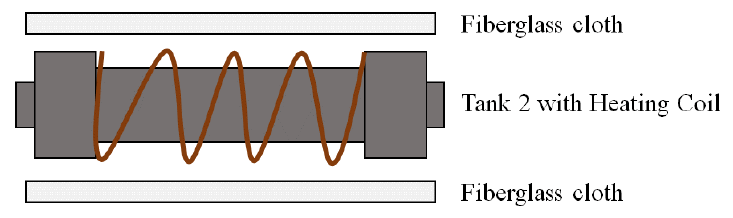
Figure 16. Secondary hydrogen production tank set-up diagram.